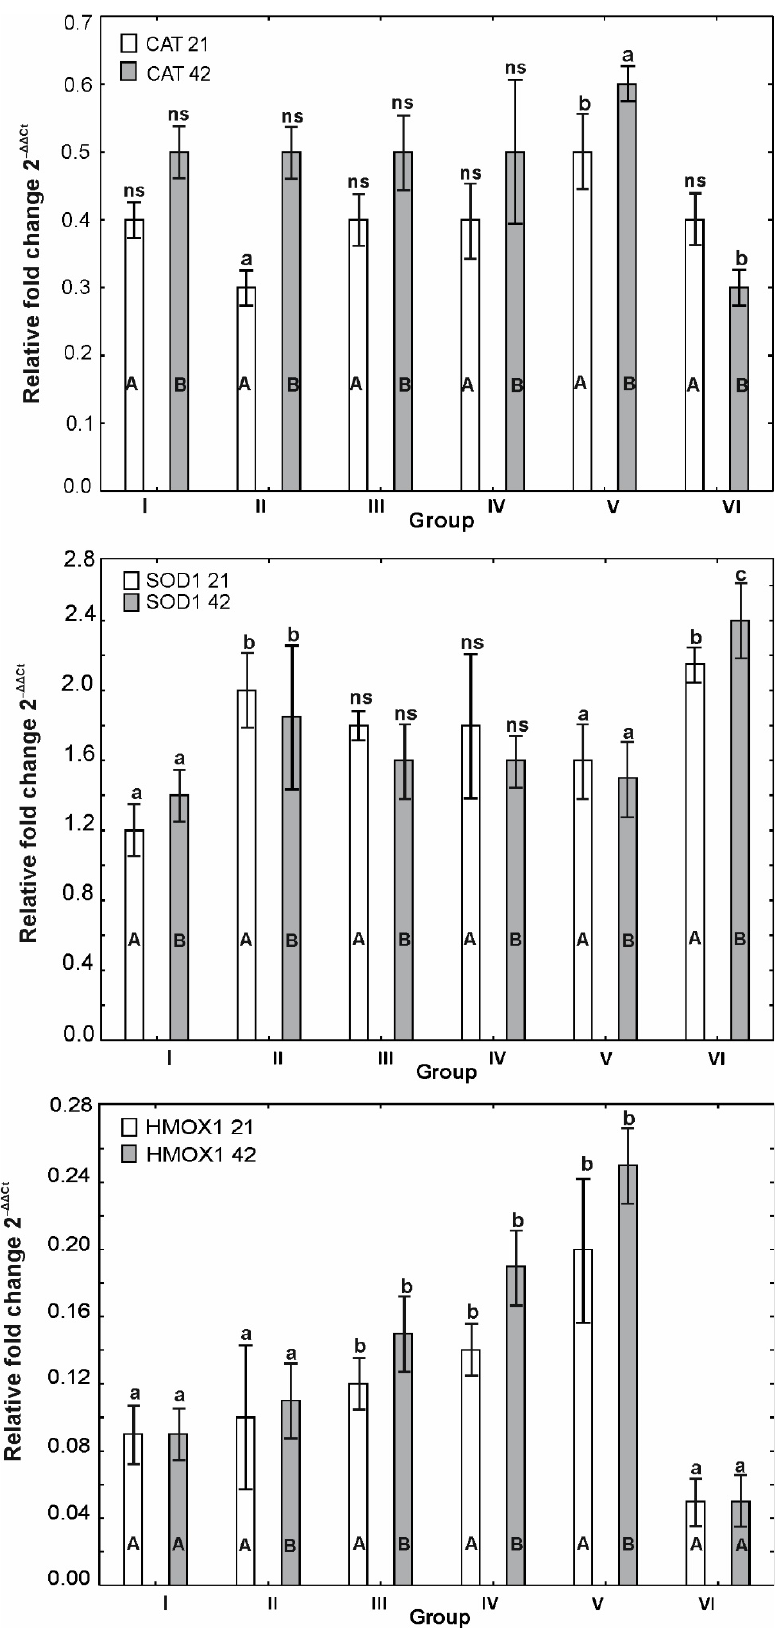
Figure 7. Results of the Kruskal–Wallis one-way ANOVA test (lowercase letters – a, b, c) and the Mann–Whitney U test (uppercase letters – A, B) for CAT—catalase, SOD1—superoxide dismutase